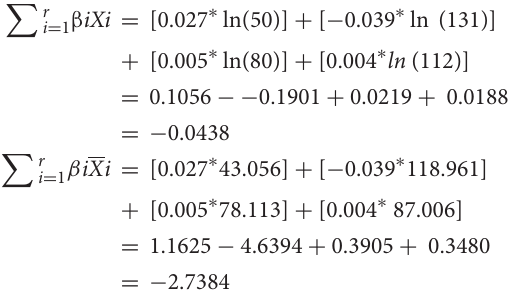
FIGURE 5 | Gender_KM